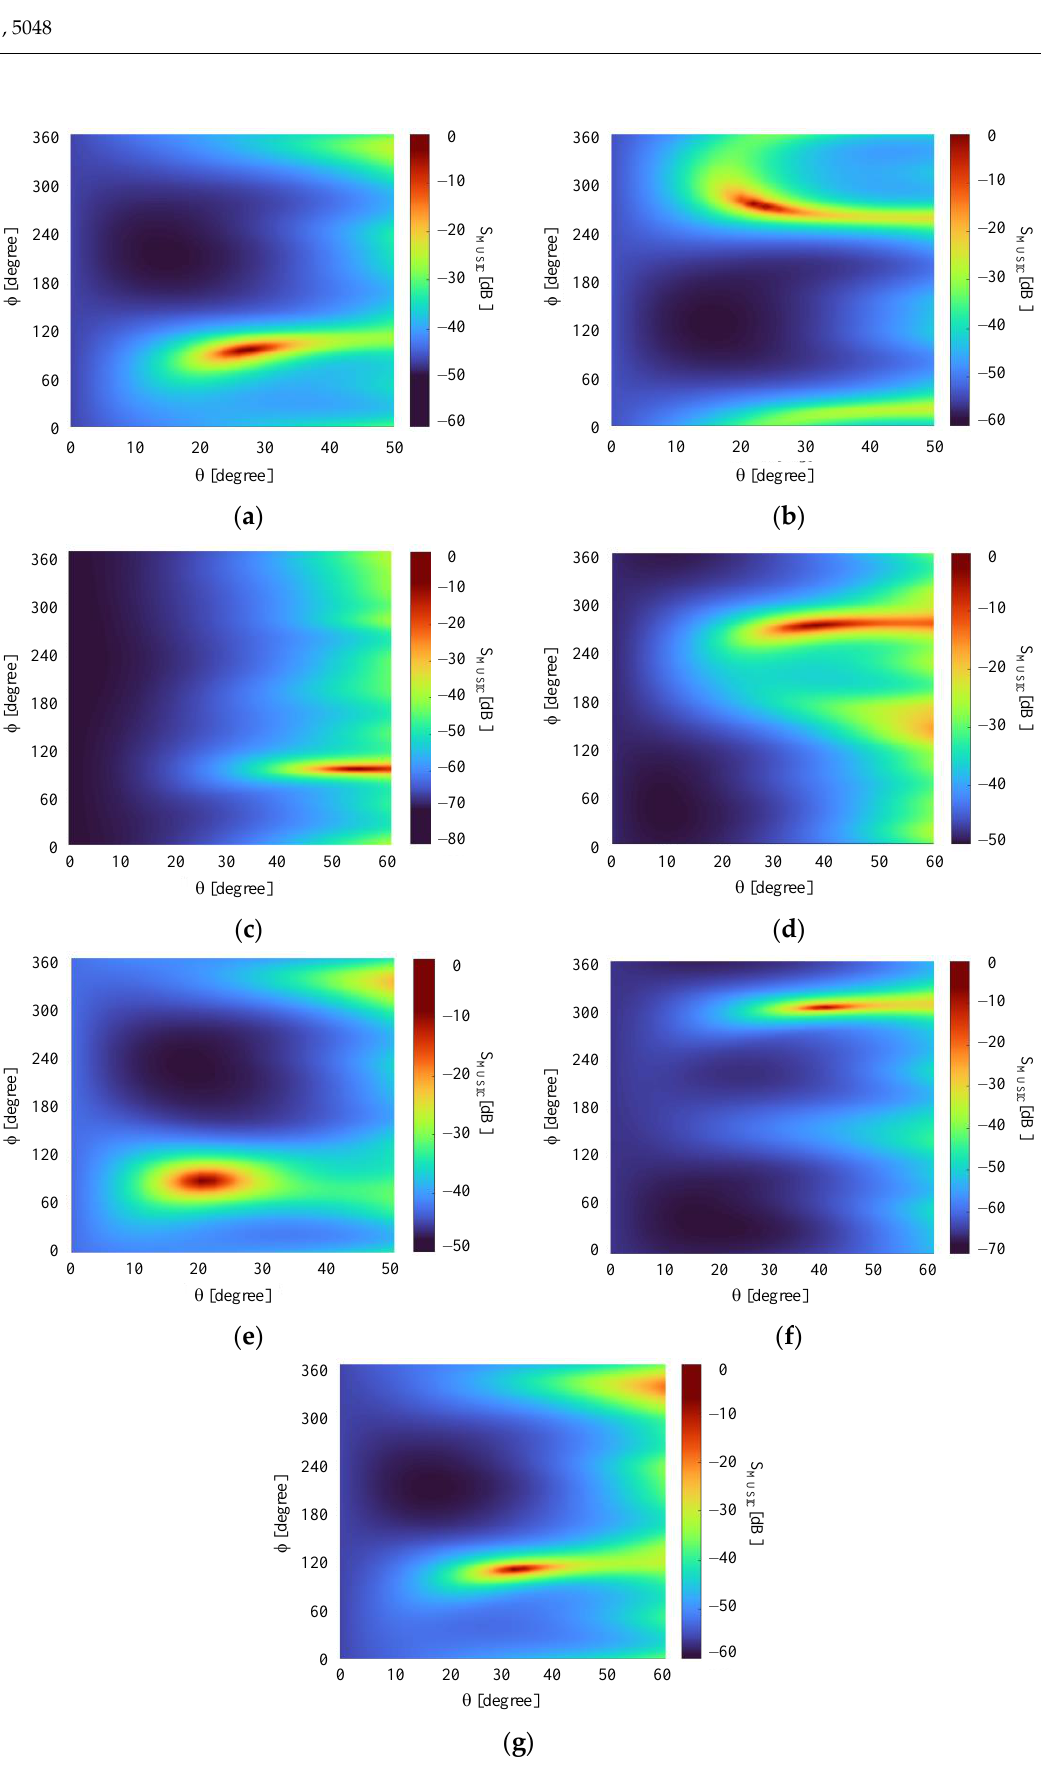
( b ) Figure 18. S MUSIC plots for the array of four isotropic radiators: ( a ) Case 1; ( b ) Case 5.